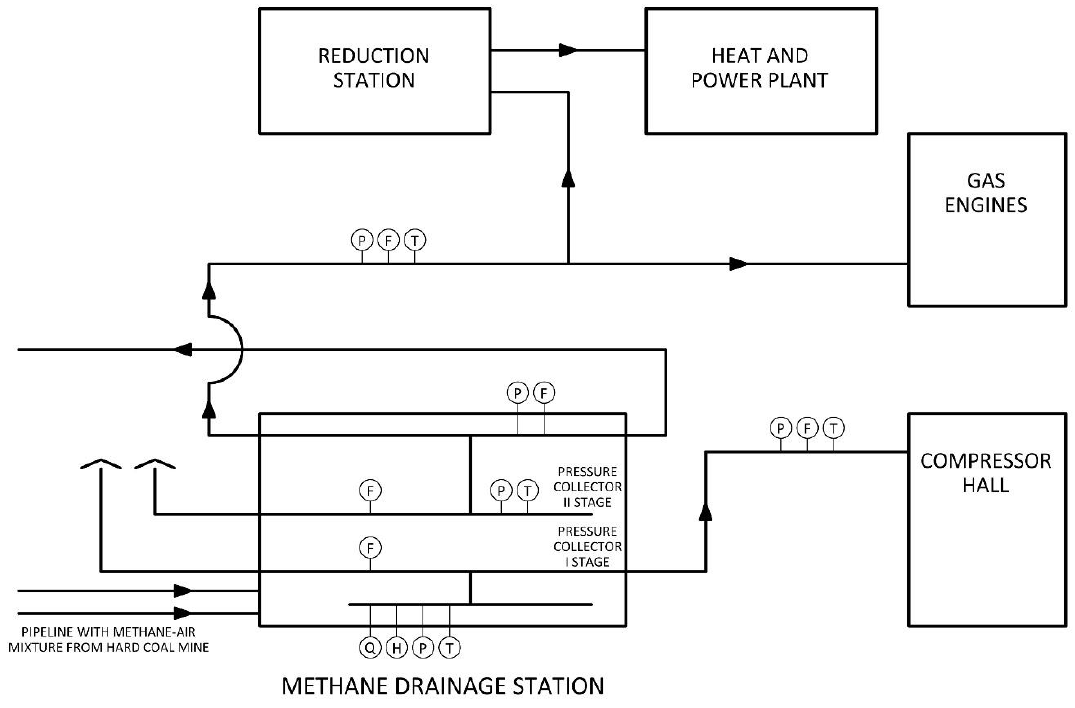
Figure 7. The Pniówek coal mine methane utilization measuring system: T—gas temperature measurement; H—gas humidity measurement; P—gas pressure measurement; F—gas flowrate measurement; Q—gas quality measurement [23].